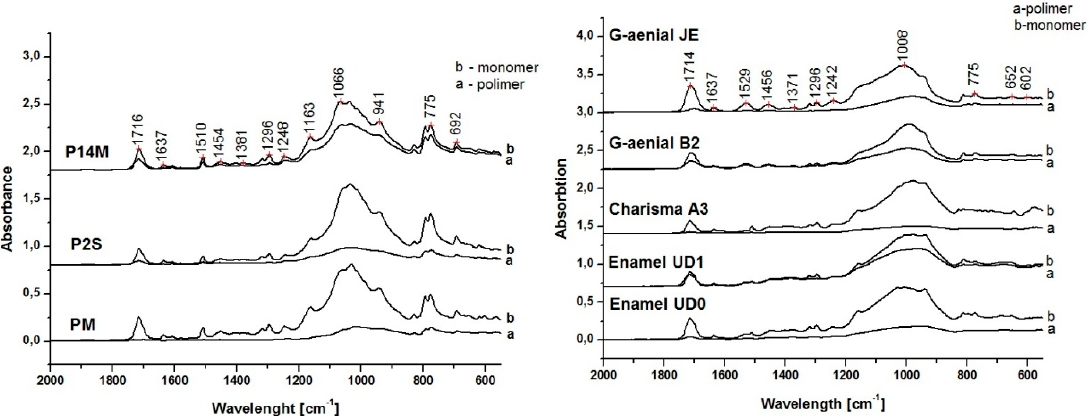
Figure 1. FTIR-ATR spectra of commercial and experimental dental composites for determining the absorbance of ν (C = C) and ν (CH 2 ) vibrations, before and polymerization. The RDB values for tested resin composites are presented in Figure 2.